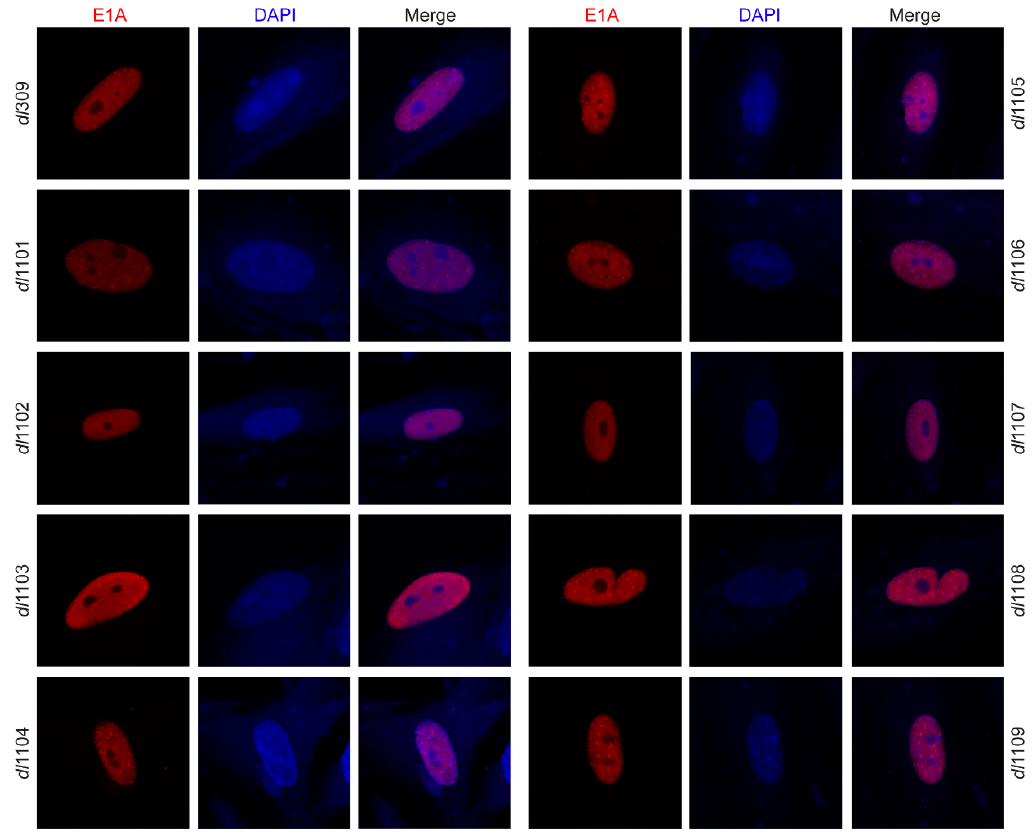
Figure 3. E1A mutant sub ‐ cellular localization in primary lung fibroblasts WI ‐ 38. WI ‐ 38 cells were grown until confluence at which point medium was replaced and cells were incubated for 72 h before infection with the indicated viruses at a MOI of 100. Twenty ‐ four hours after infection cells were fixed and stained for E1A (red) using the M73 anti ‐ E1A antibody. DAPI was used as a nuclear counterstain. Images were then acquired on a Zeiss LSM700 laser confocal microscope using the 63× objective lens.